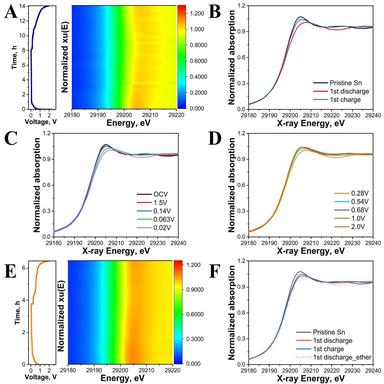
(A) 2D contour plot of in situ Sn K-edge XANES data of microsized Sn anode during charge/discharge in ether-based electrolytes. (B) The corresponding Sn Kedge XANES spectra for the pristine electrode, first discharge state and first charge state. Typical Sn K-edge XANES spectra collected at different potential during the first (C) discharge and (D) charge process. (E) 2D contour plot of in situ Sn K-edge XANES data of microsized Sn anode during charge/discharge in carbonate-based electrolytes. (F) The corre